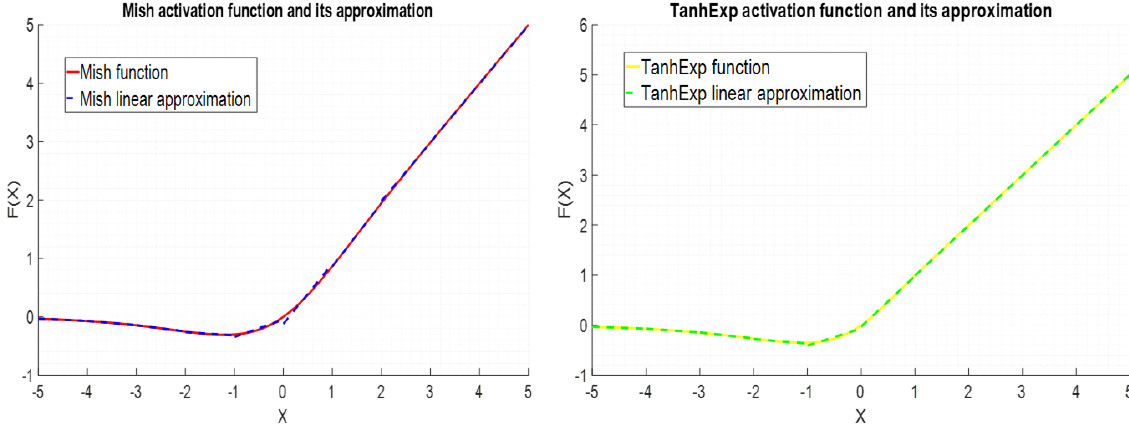
Figure 9. Graph of the TanhExp and Mish activation functions and their PWL approximations on the [ − 5, 1] interval.